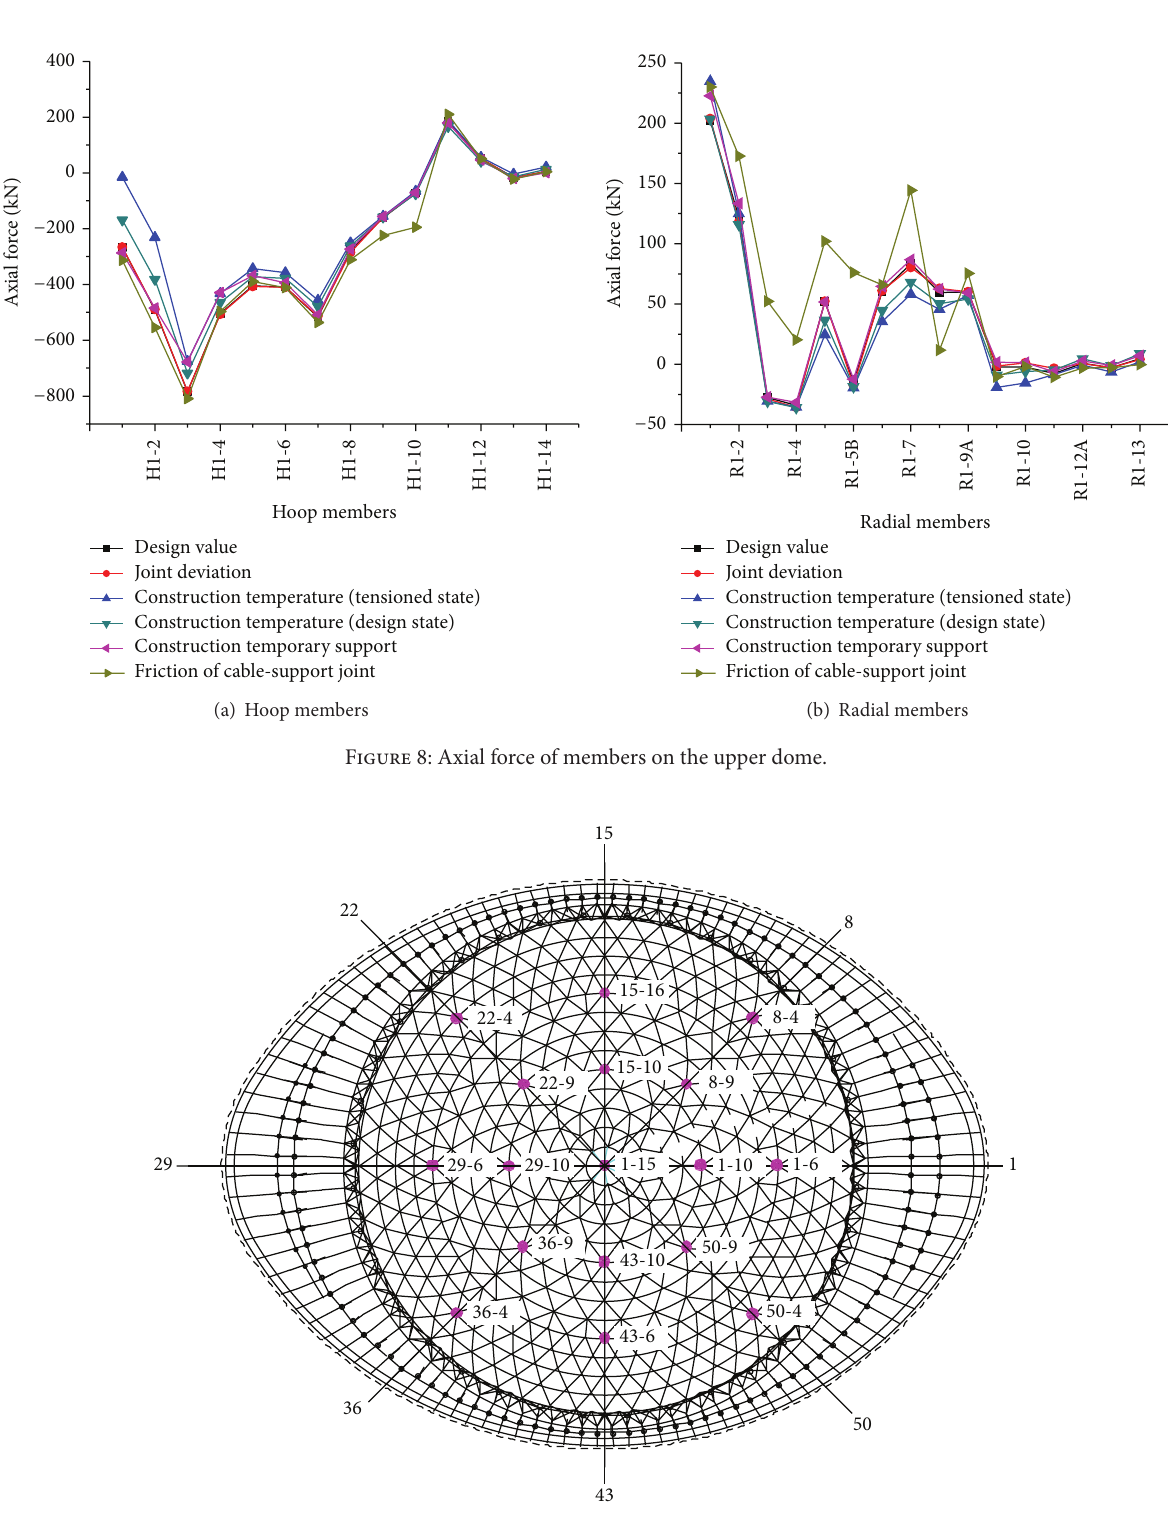
Figure 9: Layout of vertical displacement measuring